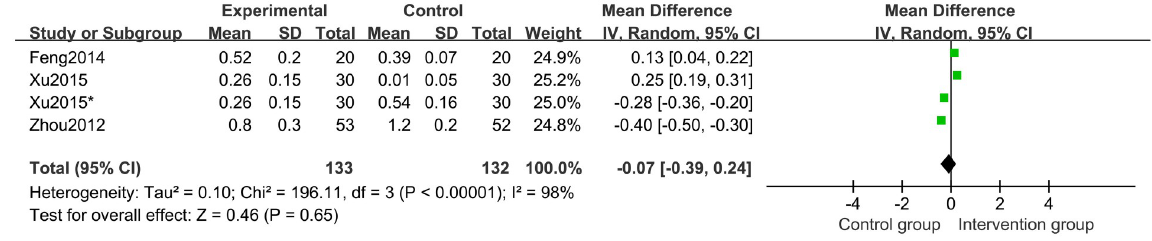
Fig 13. Forest plot of change in HtSDS ( Δ HtSDS).